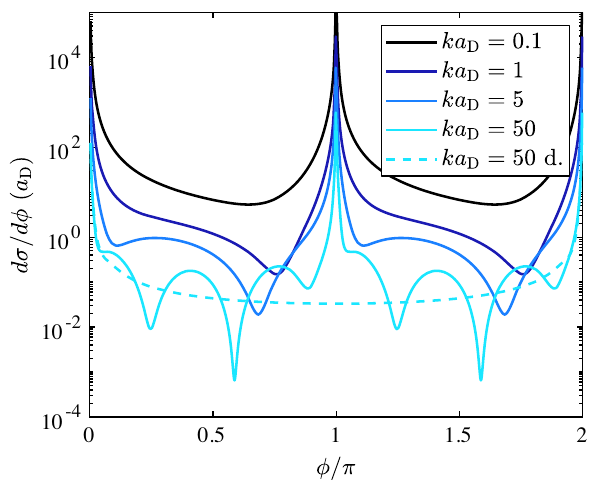
FIG. 4. Differential scattering cross section d σ =d ϕ in units of the dipolar length a as a function of the scattering angle ϕ for a D dipole interaction potential V between bosonic impurities ii immersed in a ν ¼ 0 . 5 FQH fluid. The different solid curves correspond to indistinguishable impurities with different values of the relative incident momentum ka . The larger ka , the more D D visible is the fringe pattern resulting from the interference of direct and exchange scattering channels. For comparison, the 50 : In dashed curve shows distinguishable impurities at ka D ¼ this case, no interference fringe is